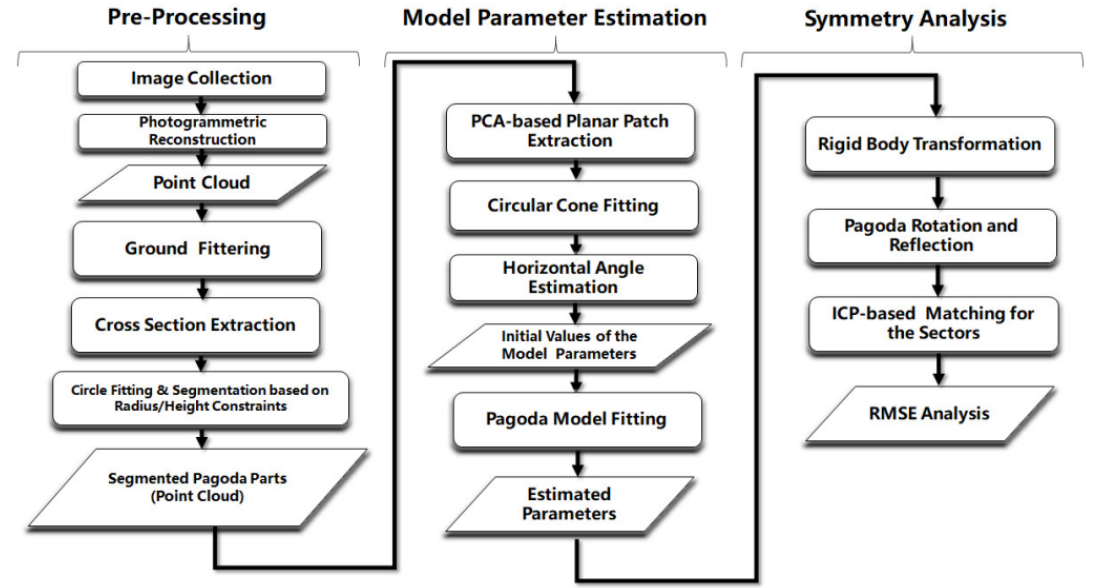
Figure 1. Workflow of the proposed method for the symmetry analysis of the polygonal